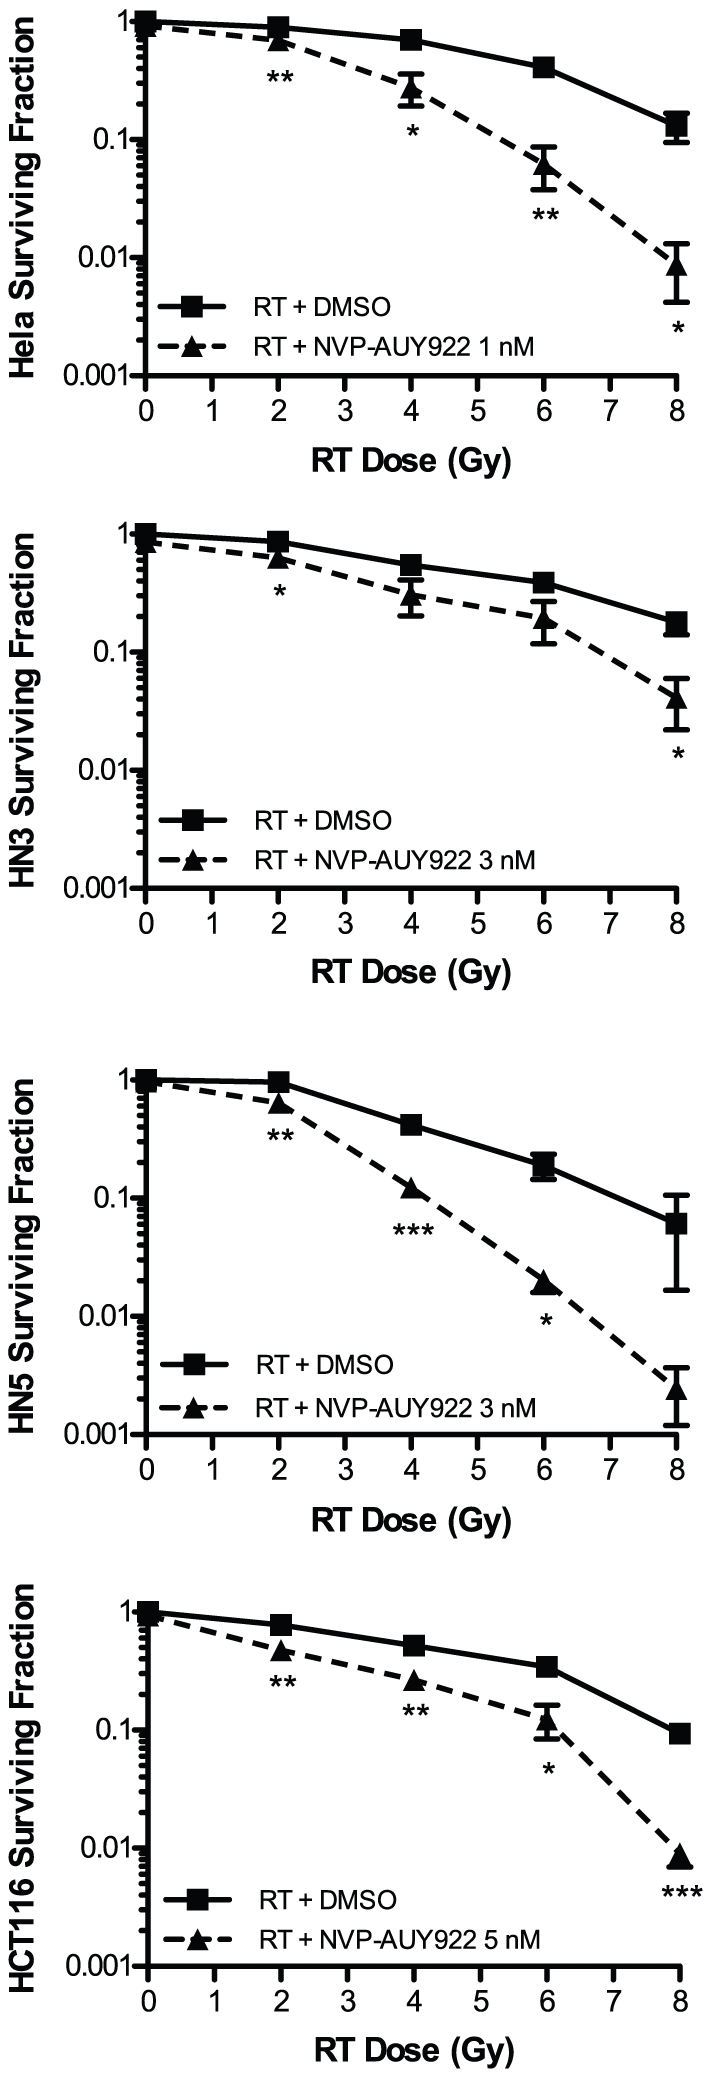
NVP-AUY922 decreases clonogenic survival due to ionising radiation in vitro.Clonogenic assay was utilised to assess radiosensitization by NVP-AUY922 in vitro against the uterine cervical carcinoma and colorectal carcinoma cell lines HeLa and HCT116 and the HNSCC cell lines HN3 and HN5. After plating at an appropriate seeding density and allowed to attach, cells were exposed to NVP-AUY922 at the concentrations indicated per cell line for 24 h to facilitate downstream effects of HSP90 inhibition to occur. Cells were subsequently exposed to ionising radiation at the doses indicated. Colony formation was determined at 10 to 14 days after irradiation and surviving fractions calculated relative to plating efficiencies for vehicle only non-irradiated cells. Data ± SEM with statistical analysis carried out by two-tailed t-test between surviving fractions at each radiation dose, *p<0.05, **p<0.01, ***p<0.001.